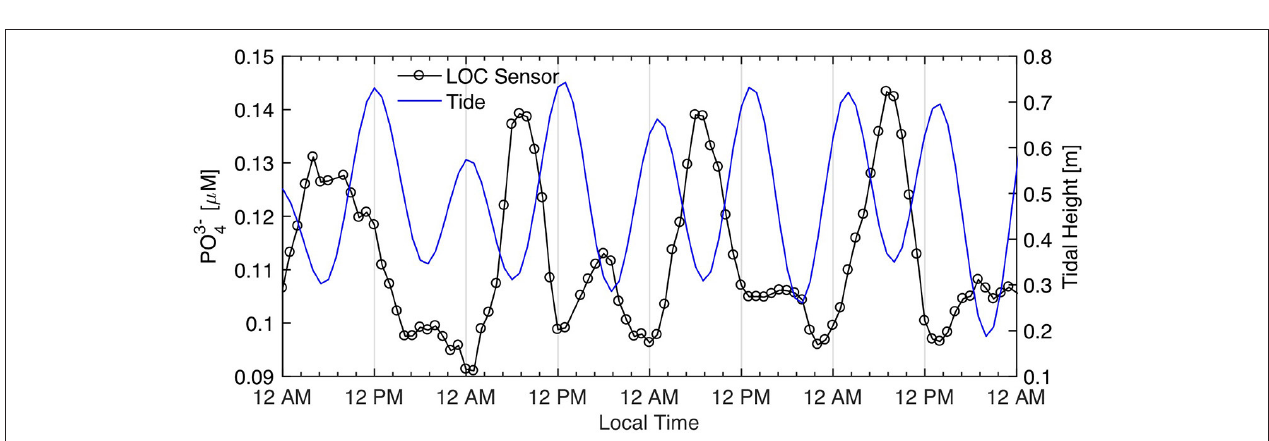
FIGURE 11 | Kaneohe Bay phosphate time-series from Sensor 2. High frequency noise in the salinity data past 20/10 was removed to produce the salinity plot. The phosphate data displayed are from the long channel. The long channel raw voltages were drift corrected to compensate for variations in the intensity of the LEDs. The phosphate concentrations were calculated using a linear regression forced through the origin using the two onboard phosphate standards.